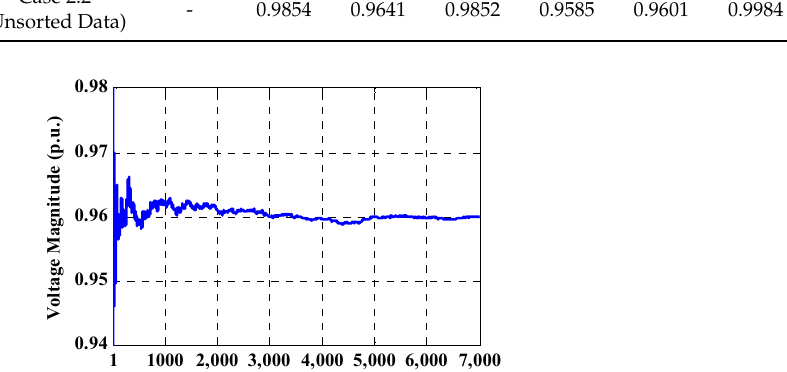
Figure 12. Convergence process of bus-53 for unsorted data-based MCS. Table 6. Calculation run-time results for proposed method, based on both simple MCS and data clustering (69-bus system).